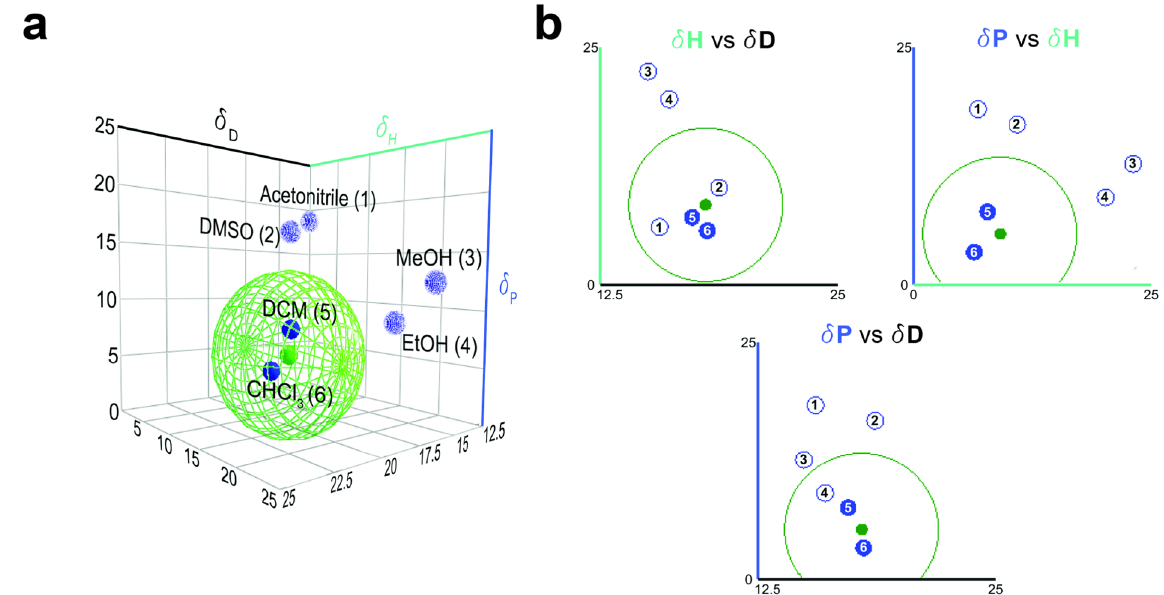
Figure 1. Polymer and solvents in the 3-D Hansen space: ( a ) PCL solubility sphere and positions of solvents visualized in 3-D Hansen space; non-solvents Acetonitrile (1), DMSO (2), MeOH (3), EtOH (4) are located outside of the PCL sphere, good solvents DCM (5) and CHCl3 (6) inside the PCL sphere ( b ) solvents (Acetonitrile (1), DMSO (2), MeOH (3), EtOH (4), DCM (5) and CHCl 3 (6)) located in 2D projected